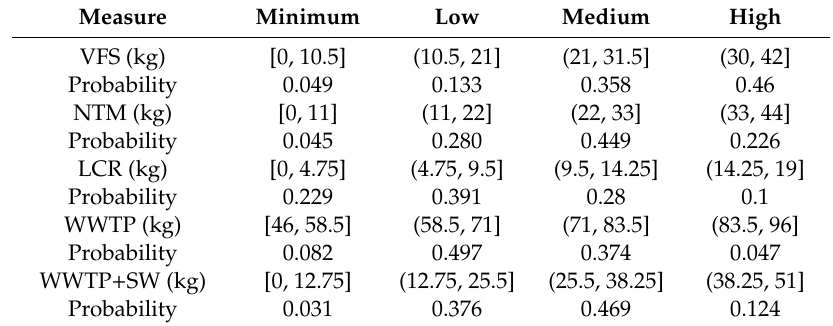
Table 3. E ff ectiveness intervals for groups of measures entering the analysis and their